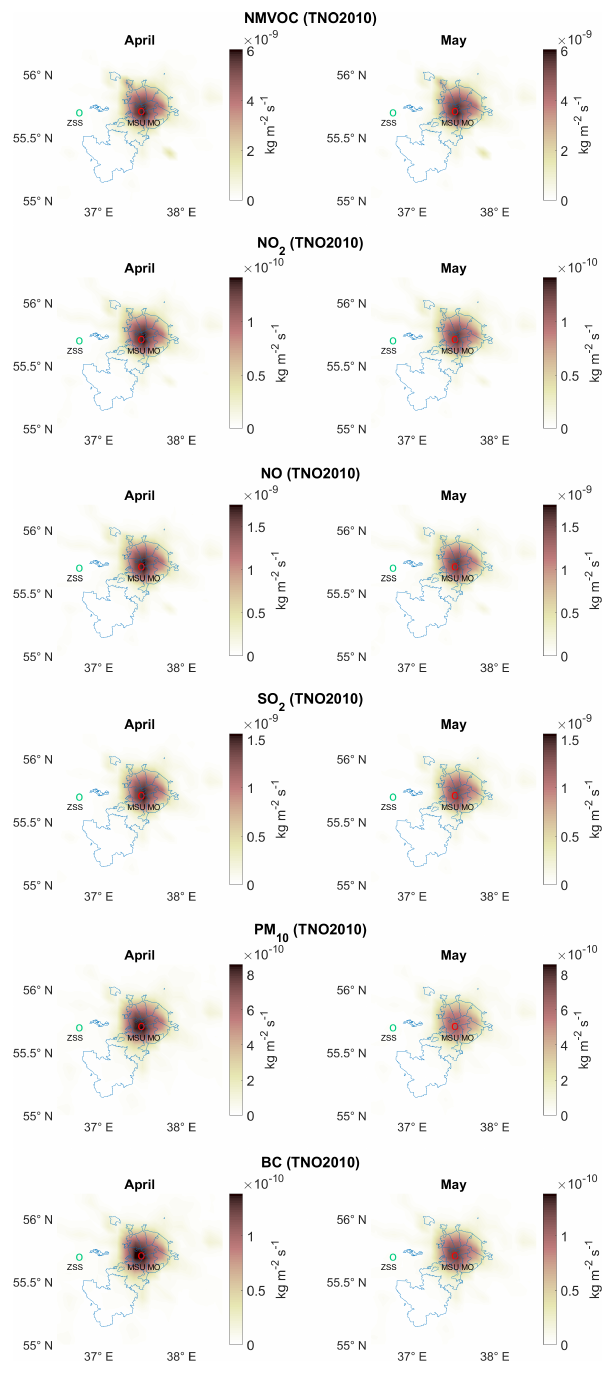
Figure 2. Monthly mean emissions of aerosol gas precursors, PM 10 and BC emissions according to the TNO2010 inventory in April and May in the Moscow region. The location of the Moscow State University Meteorological Observatory is shown by a red circle and the Zvenigorod site by a green